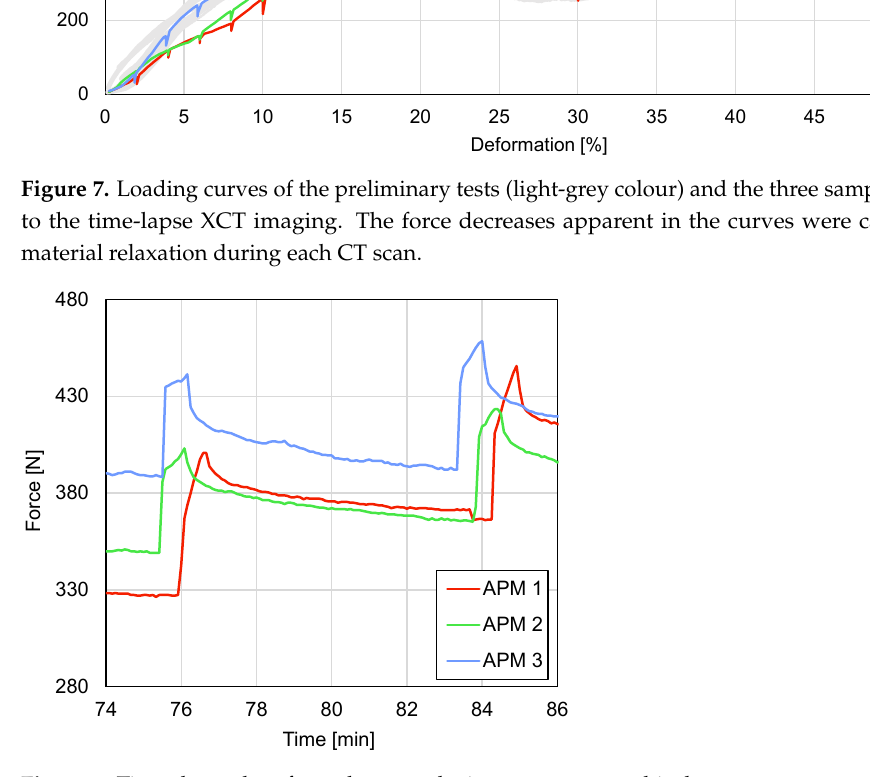
Figure 8. Time-dependent force decrease during one tomographical scan.